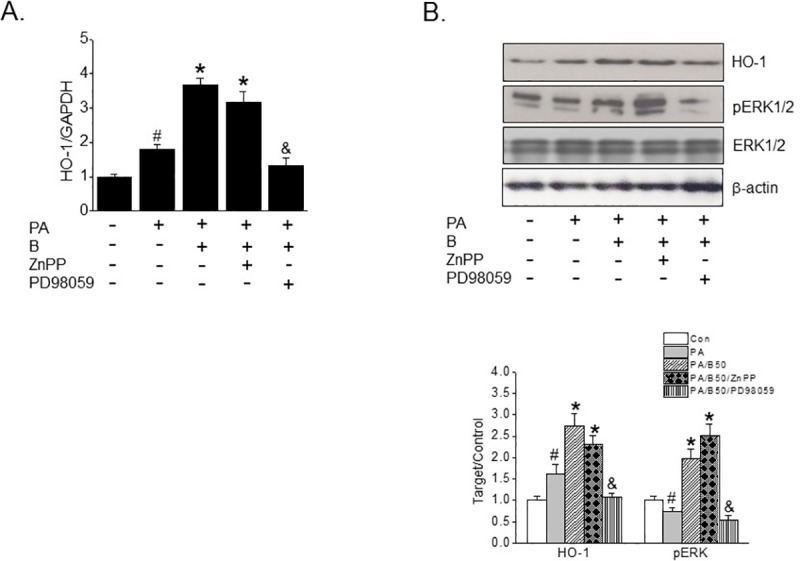
Effects of ERK activation on baicalein-induced HO-1 expression.INS-1 cells were pretreated with baicalein (50 μM) for 3 h in the absence or presence of ZnPP (10 μM), or PD98059 (10 μM) and then PA (500 μM) was added and incubation continued for a further 8 h (for qPCR) or 24 h (for western blot). The mRNA expression of HO-1 (A) and protein levels of HO-1, pERK1/2 and ERK1/2 (B) were assessed by qPCR or western blotting, respectively. Results are representative of three independent experiments and are presented as means ± SDs. #P<0.05 vs. controls; *P<0.05 vs. PA alone; &P<0.05 vs. PA plus baicalein treatment.